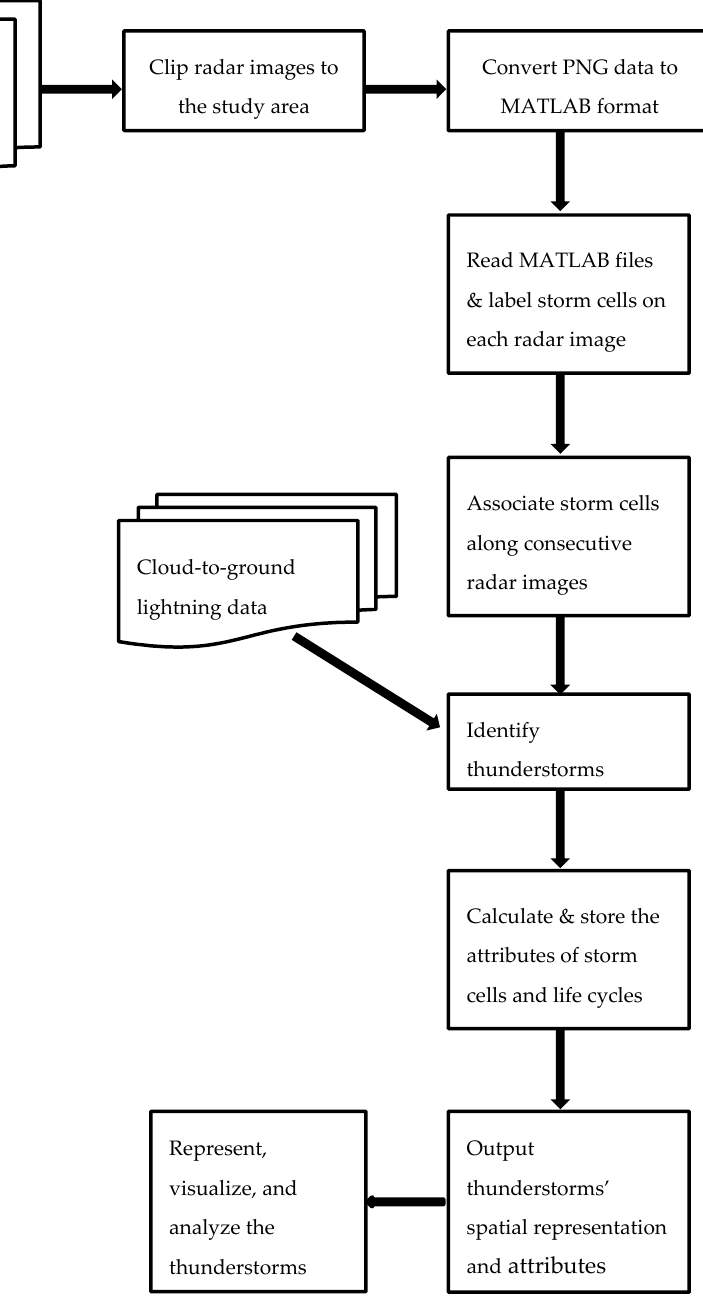
Figure 3. The workflow of identifying, representing, and analyzing thunderstorms.